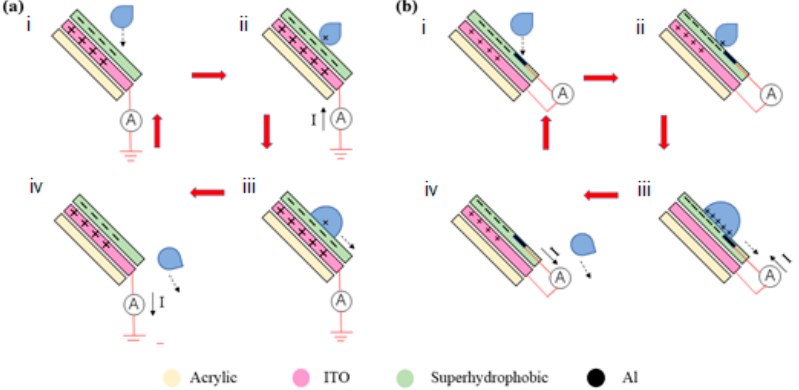
Figure 7. The working mechanism of energy harvesting with superhydrophobic coating. ( a ) Without and ( b ) with an aluminum electrode. i. The droplet falls towards the fluorocarbon/silica superhydrophobic coating. ii. The droplet contacts with superhydrophobic coating. iii. Droplet spreads on the surface and contacts with the aluminum electrode. iv. The droplet leaves the surface.